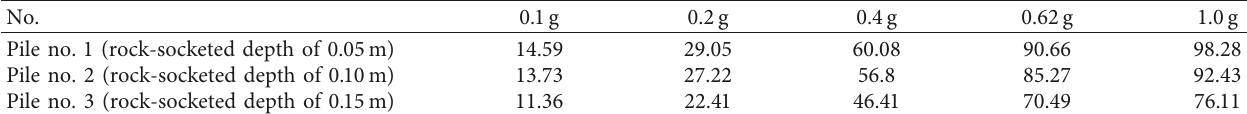
Figure 4: El Centro waves under five conditions. (a) 0.1g El Centro wave, (b) 0.2g El Centro wave, (c) 0.4g El Centro wave, (d) 0.62g EL Centro wave, and (e) 1g El Centro wave. Table 2: Peak displacement of piles under different working conditions